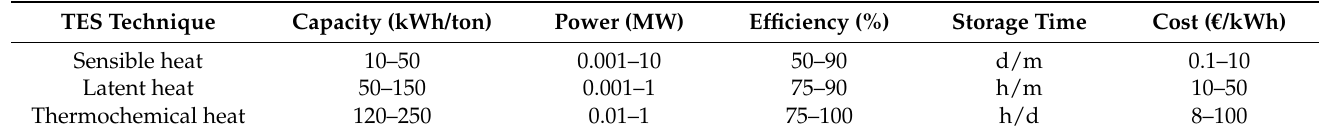
Table 2. Comparison of TES solutions